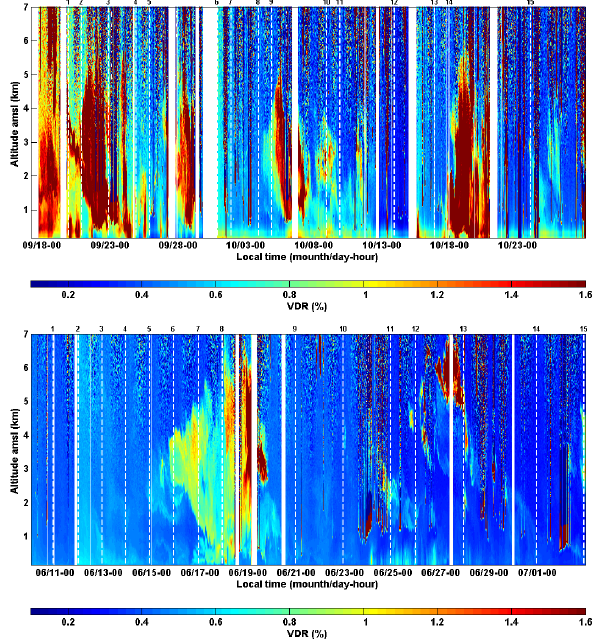
Figure 6. Volume depolarization ratio (VDR in %) evolution as a function of altitude (in km) during HyMeX (up) and ChArMEx (down) comparison experiments . The vertical white dotted lines identify the coincidences with the CN at the top. The color bar ranges from low VDR (blue) to high ones